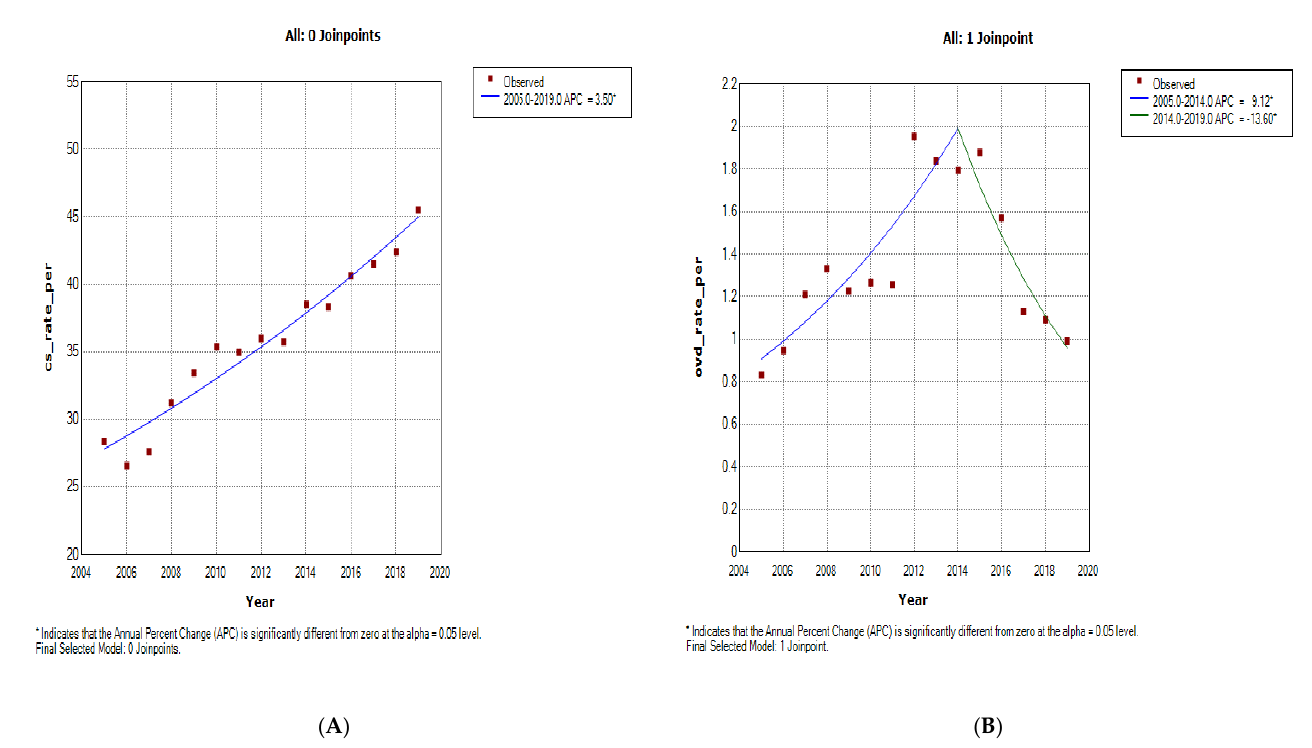
Figure 2. Join point regression analysis of the trends in caesarean section ( A ) and operative vaginal delivery rates ( B ) at Chris Hani Baragwanath Academic Hospital (2005 – 2019).